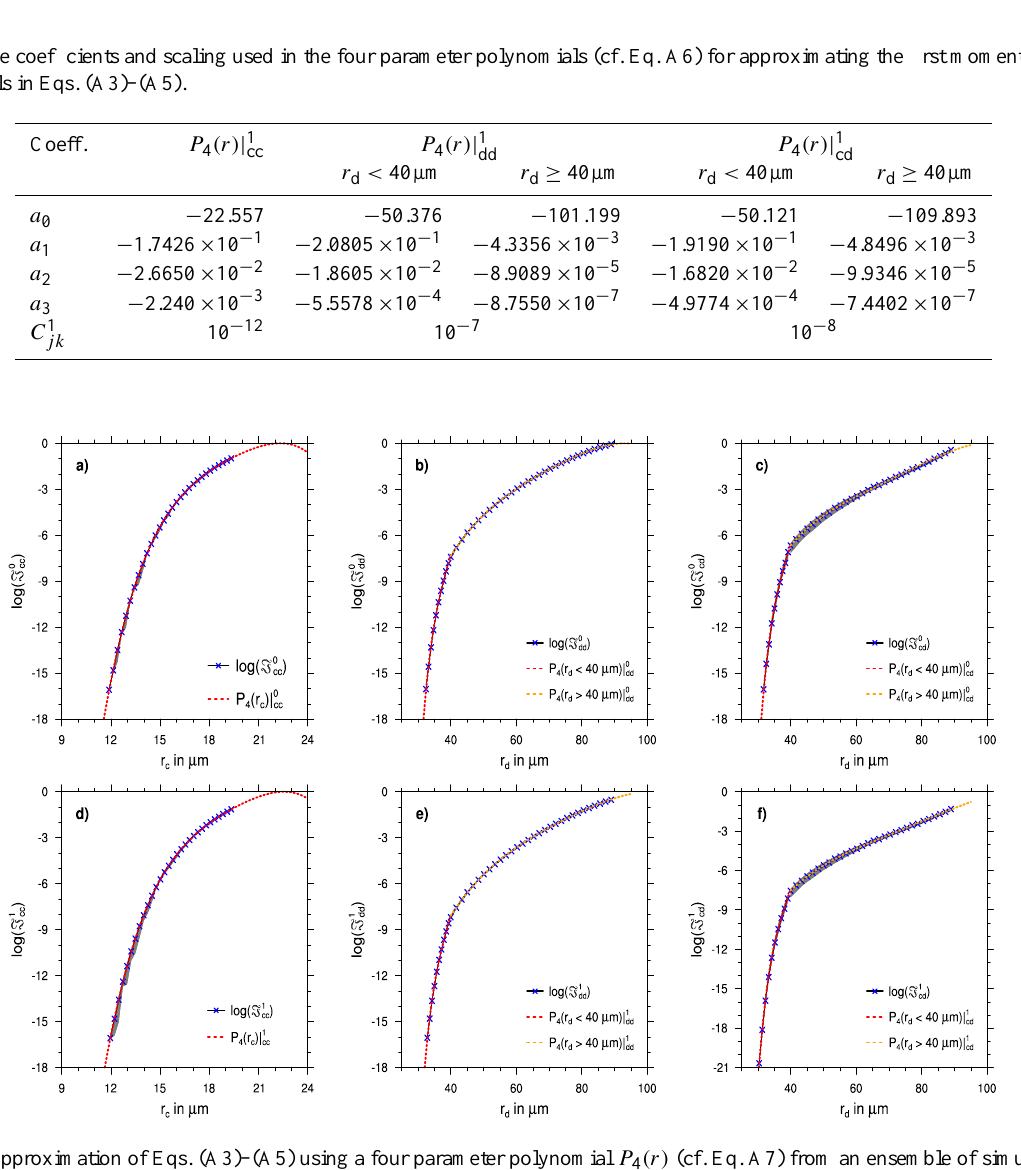
Figure A1. Approximation of Eqs. (A3)–(A5) using a four parameter polynomial P 4 (r) (cf. Eq. A7) from an ensemble of simulations with the 1-D kinematic cloud model (Sant et al., 2013). The gray area in the figures represents the range of the minimum and maximum values. Note that the gray area in (a, b) and (e) are very small and hardly